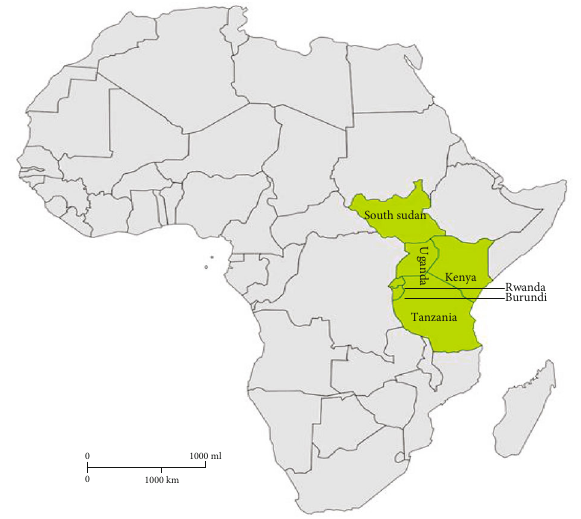
Figure 1: Location of EAC countries on the map of